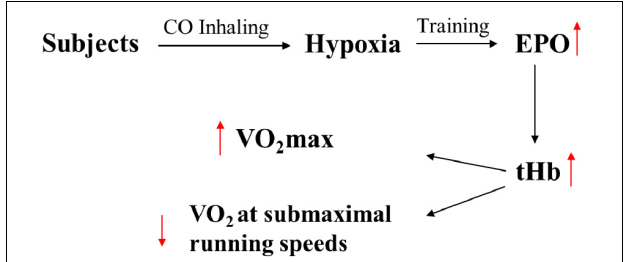
FIGURE 3 | The assumed physiological reasons of improving in performance caused by inhalation of CO. The EPO and tHb are erythropoietin hormone and total